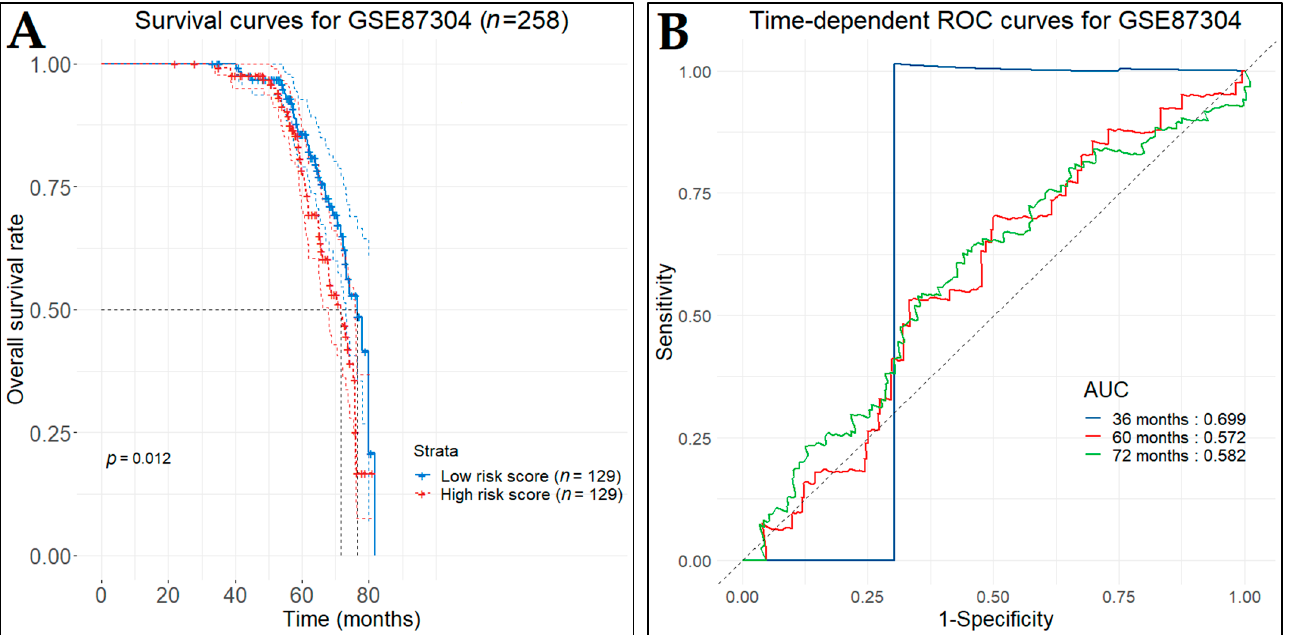
Figure 22. Survival analysis using the GSE87304 ( n = 258) dataset (first test set). ( A ) Kaplan–Meier curves for disease-free survival of MIBC patients who received cisplatin-based chemotherapy as stratified by the six-gene predictive index. Patients were divided into low- and high-risk groups according to the median predictive index. ( B ) Time-dependent ROC curves (three-, five-, and six-year predictions) to assess the predictive accuracy of the six-gene predictive model.